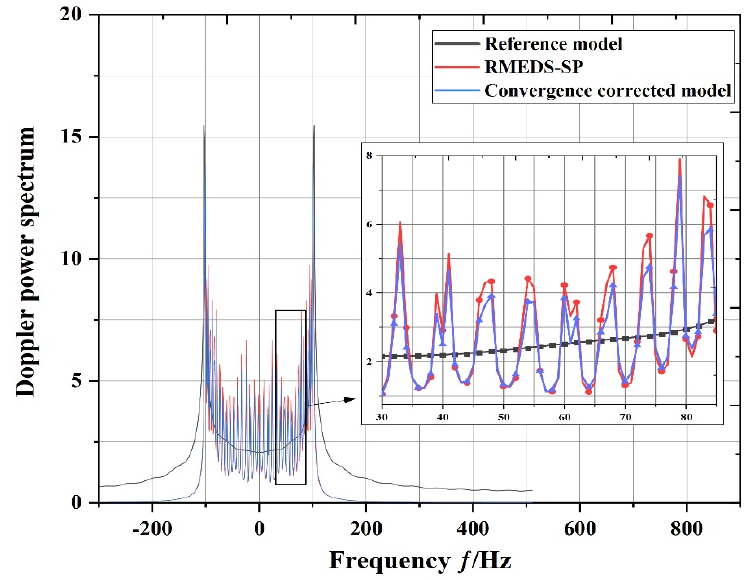
Figure 13. DPS of RMEDS-SP and after error compensations.